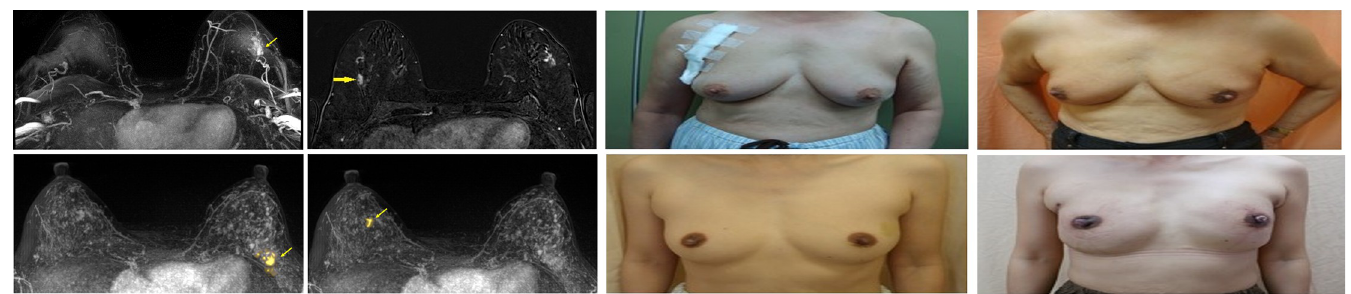
Fig 2. (a-h) Case A: A 75-year-old patient was mammography diagnosed with left breast tumor primarily but the contralateral lesion was found via MR Imaging. She received a bilateral endoscopy assisted partial mastectomy. The final pathology proved the infiltrating ductal carcinoma (IDC) in the right. (e-h) Case B: A 49-year-old patient with pathologic diagnosed of ductal carcinoma in situ (DCIS) of left breast. The contralateral lesion was found via MRI before operation. According to her family history of breast cancer, she received an endoscopic assisted bilateral nipple-sparing mastectomy with immediate breast reconstruction. The final pathology proved bilateral